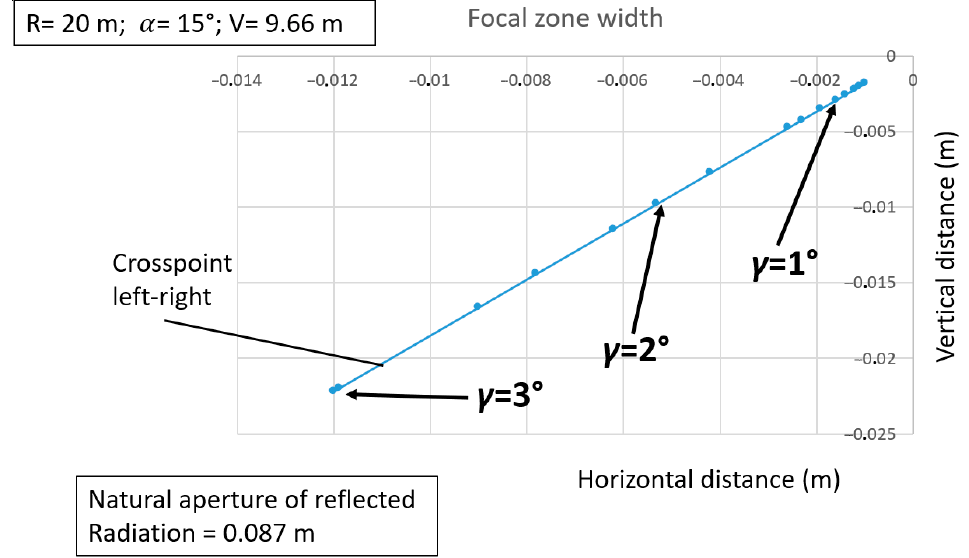
Figure 10. Position of the left-right cross-point for different values of γ .